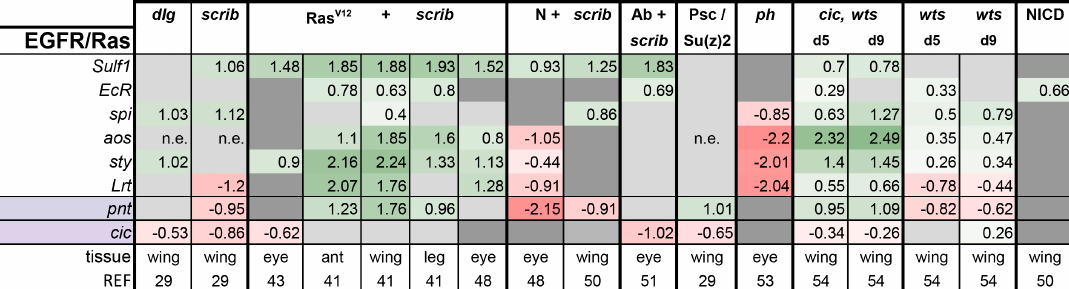
Figure 2. Epidermal growth factor receptor (EGFR) / Ras activation is not a prerequisite for tumor formation. Light purple highlights the transcription factors of the pathway. Note that pnt is a transcription factor and also a transcriptional target of the pathway. Gene expression is displayed in log2FC. Color coding corresponds to a heatmap with a scale from − 5 (dark red, downregulation) to 5 (dark green, upregulation). Light grey cells represent non-significant changes with p ≥ 0.05. Dark grey: the gene was not found in the dataset. n .e. = not expressed, the gene was in the data, but showed 0 reads. Abbreviations: Sulfated, Sulf1; Ecdysone receptor, EcR spitz, spi; argos, aos; sprouty, sty; Leucine-rich tendon-specific protein , Lrt ; pointed, pnt